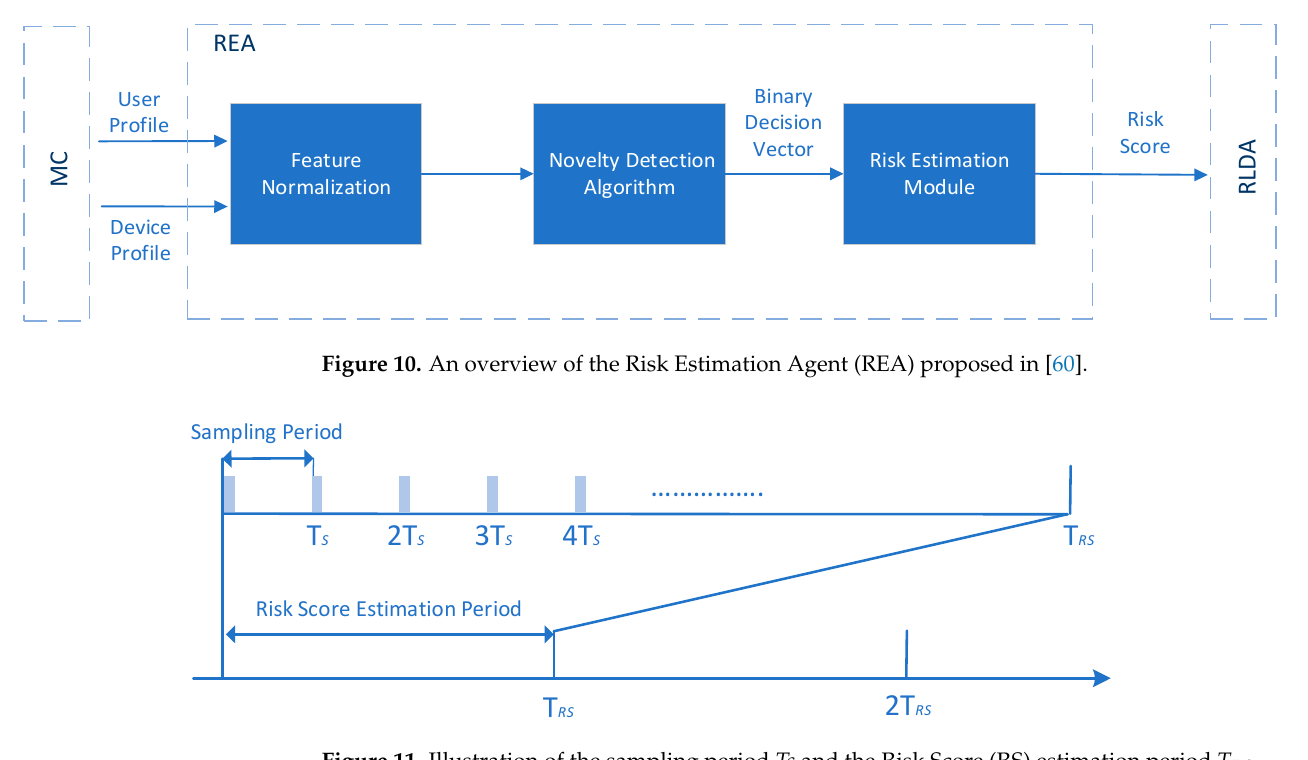
Figure 11. Illustration of the sampling period Ts and the Risk Score (RS) estimation period T RS .